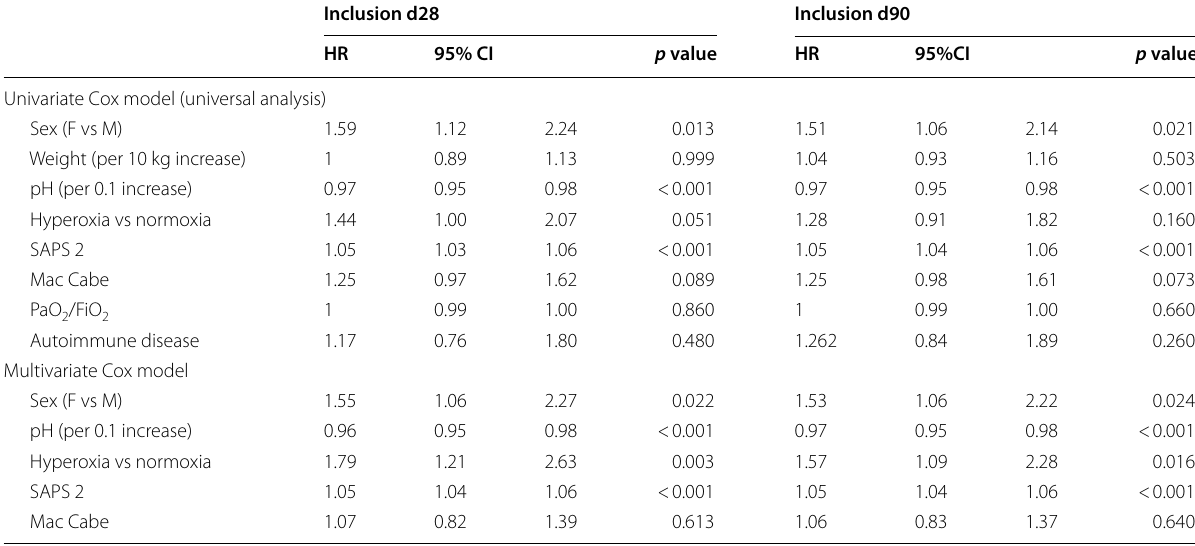
HR hazard ratio, CI confidence interval, F female, M